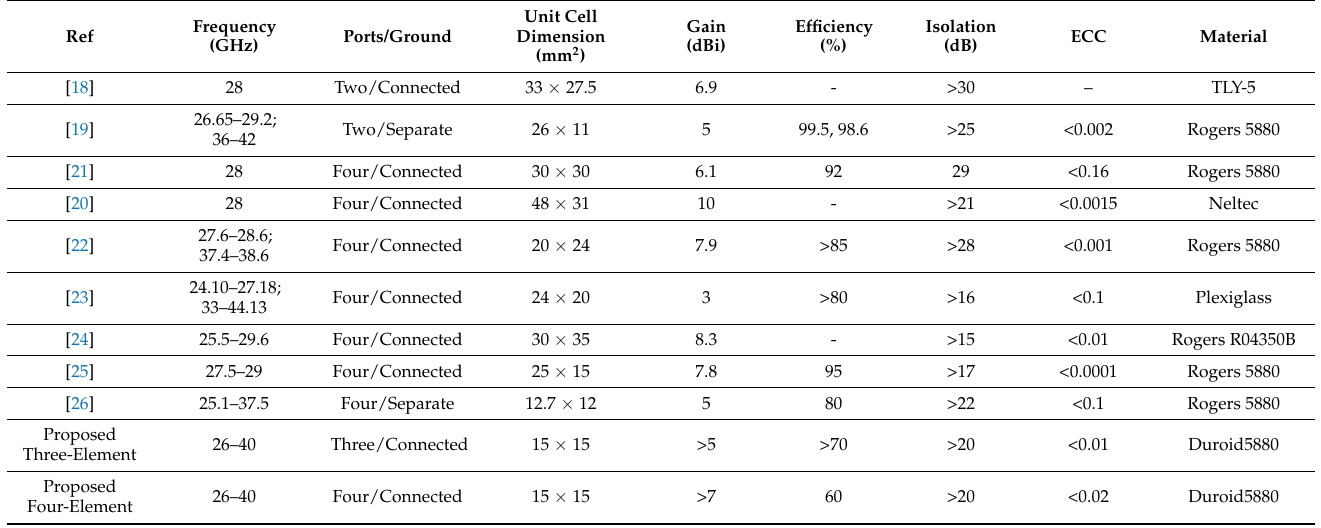
Table 1. Comparison of proposed three-element (case 1) and four-element (case 2) with other MIMO